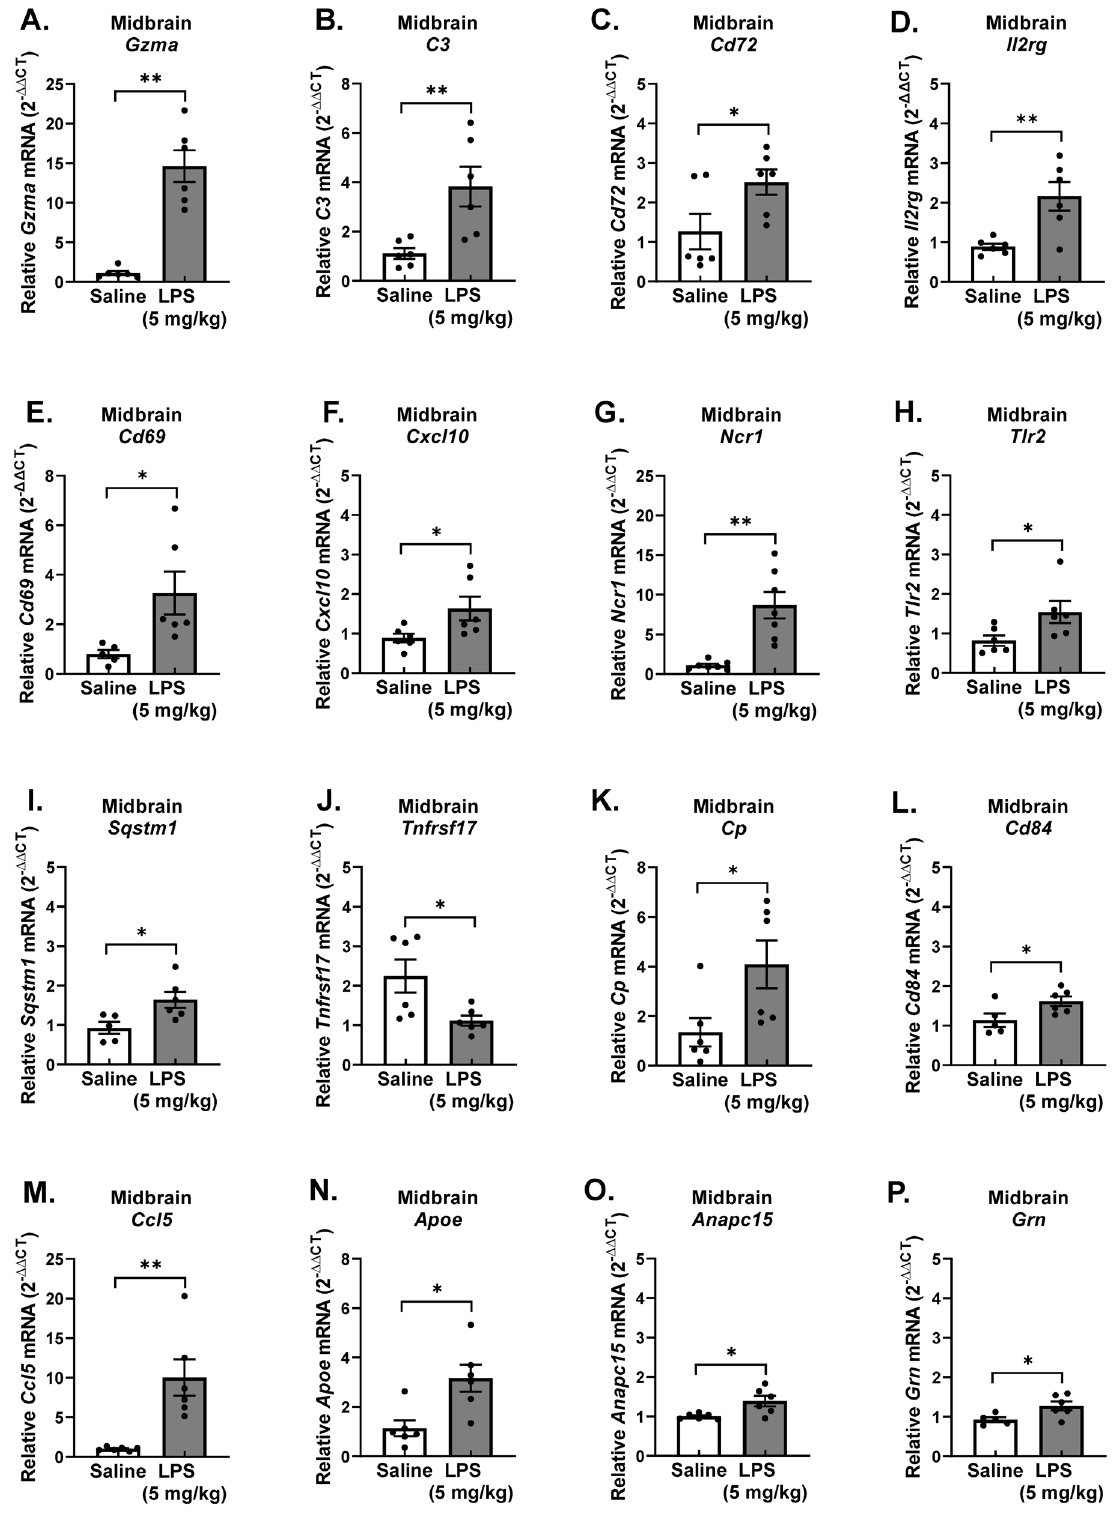
Fig. 4 Persistent pro-in fl ammatory microglia (PPM) gene expression in the midbrain during persistent neuroin fl ammation. Male C57BL/6 mice received a single IP injection of LPS or saline and midbrain mRNA gene expression of PPM genes was assessed 7 days later. ( A ) Gzma , ( B ) C3 , ( C ) Cd72 , ( D ) Il2rg , ( E ) Cd69 , ( F ) Cxcl10 , ( G ) Ncr1, ( H ) Tlr2 , ( I ) Sqstm1 , ( J ) Tnfrsf17, ( K ) Cp , ( L ) Cd84 , ( M ) Ccl15 , ( N ) Apoe , ( O ) Anapc15, and ( P ) Grn mRNA levels were analyzed by qRT-PCR and normalized to Gapdh using the 2- ΔΔ CT method. Data are reported as the mean ± SEM. * p < 0.05 and ** p < 0.01 when compared to control ( n = 4 –